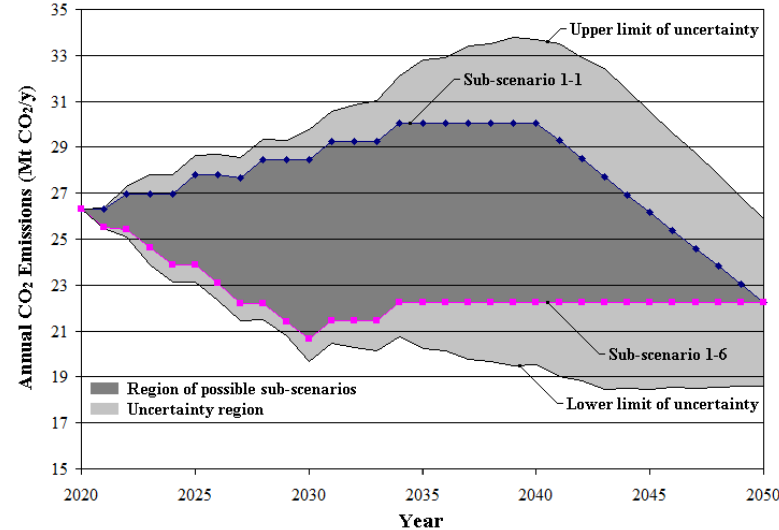
Figure 6. Region of possible sub-scenarios for annual CO 2 emissions from the Serbian electricity generation sector together with the corresponding upper and lower limits of uncertainty for the period 2020–2050, taking into account national targets relating to the independence of the electricity supply, that is, Scenario 1.